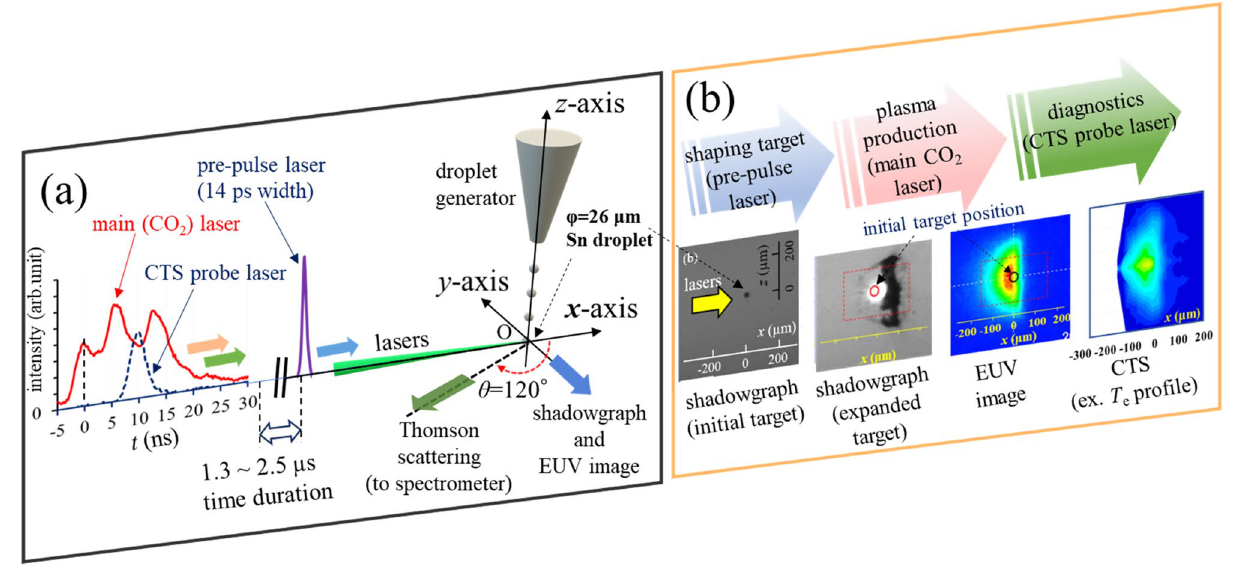
Figure 1. ( a ) Schematic view of the experimental layout and temporal profiles of the Main (CO 2 ) and the Probe lasers. ( b ) Examples of shadowgraph (initial target and expanded target), in-band EUV image, and 2D electron temperature profile in perspective view. These results in planview are shown in Fig. 2 and Supplementary Fig.